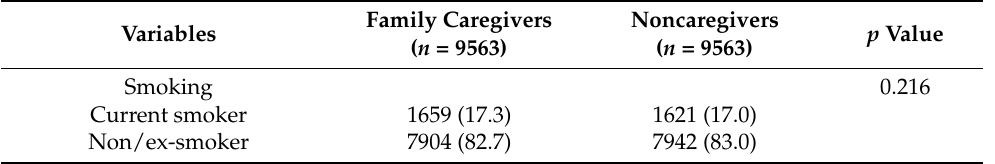
Table 4. Comparisons of the physical and mental health-related variables and HRQoL (EQ-5D) between family caregivers of people with dementia and noncaregivers in propensity-score matched